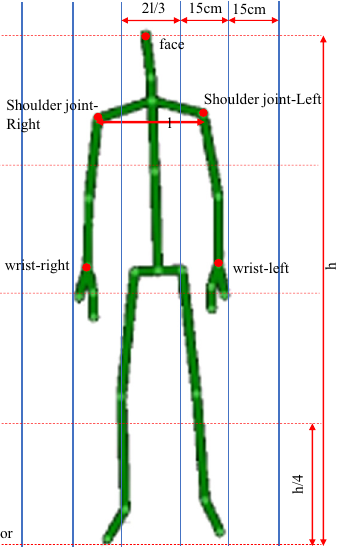
Figure 4: Dimensions and joints used to separate zones are shown in the skeletal diagram. The distance between right and left shoulder joints is denoted as l and the height from the fl oor to face joint is denoted as h . Values used for length and width are marked.